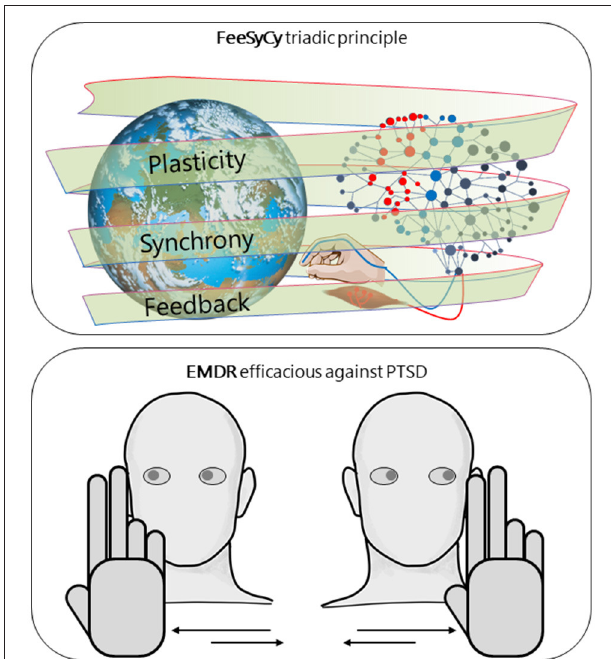
FIGURE 1 | FeeSyCy & EMDR efficacy against trauma. Graphic representation of our central hypothesis, that the triadic principle feedback-synchrony-plasticity (FeeSyCy) governs the adaptive capacity of the body-brain system and underlies the effectiveness of Eye Movement Desensitisation and Reprocessing (EMDR), an elective treatment for post-traumatic stress disorder (PTSD), an illustrative case of reduced adaptive capacity. The neuronal network, shown separately for graphic simplicity, refers to both the patient and the